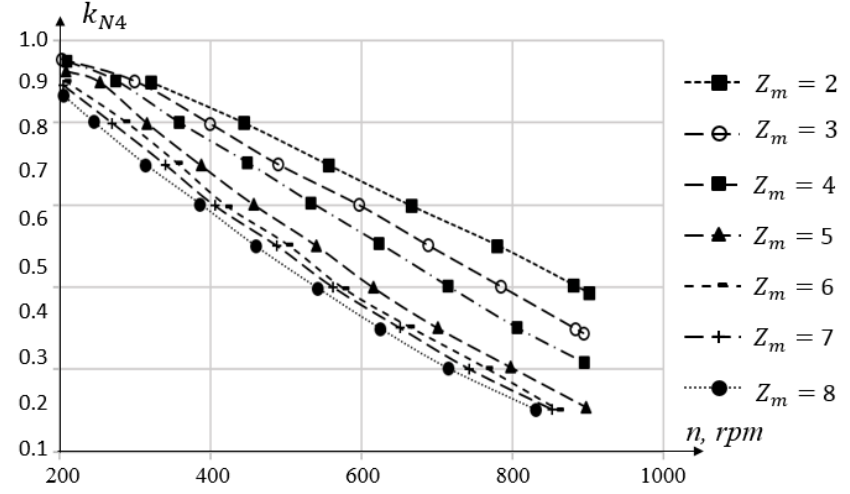
Figure 11. Influence of the number of blades ( Z m ) on the power consumed by activator ( k N 4 ) with straight blades at different speeds of rotation ( n ) (experimental data).